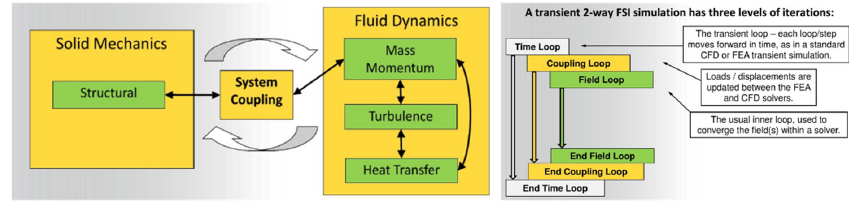
Figure 2. The system coupling and the two-way FSI simulation in ANSYS workbench.